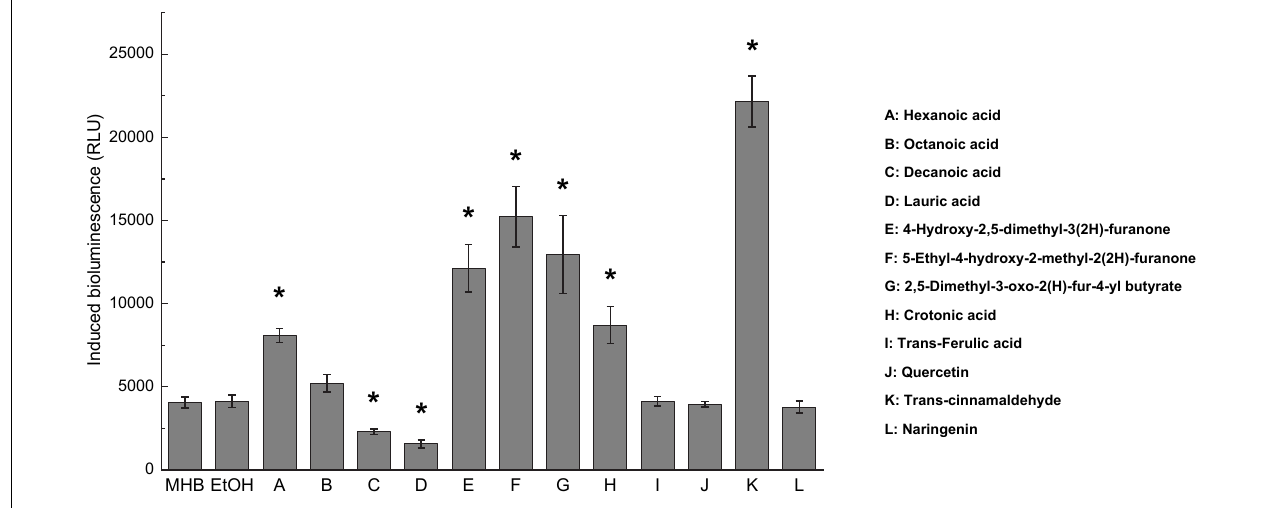
FIGURE 1 | Screening of C. jejuni autoinducer-2 inhibitor. Bioluminescence activity of C. jejuni ATCC 33560 treated with 12 different compounds was compared to the ethanol control (EtOH). MH broth containing 0.5% ethanol was used as ethanol control. Each bar represents the average of three biological replicates with standard deviation. MHB was serve as broth control and EtOH was negative control. * Statistical significance between negative control and treated samples was determined by one-way ANOVA coupled with Dunnett’s multiple comparisons test ( P < 0.05 was considered as statistically significant).